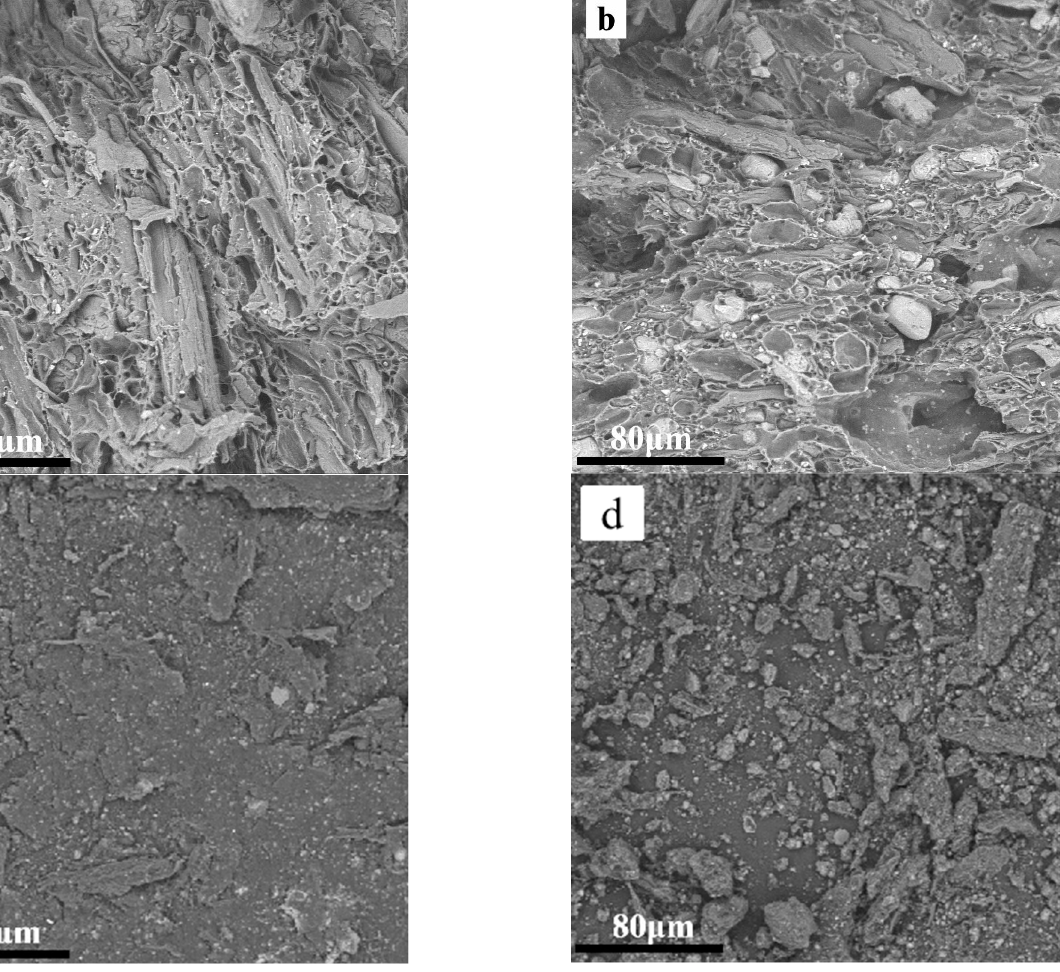
Figure 7. ( a , b ) are the material interface diagrams of WPC with different APP/ZB additions before combustion ( a ) 0; ( b ) 20 wt%. ( c , d ) are the carbon interface diagrams of WPC with different APP/ZB additions after combustion ( c ) 0; ( d ) 20 wt%.